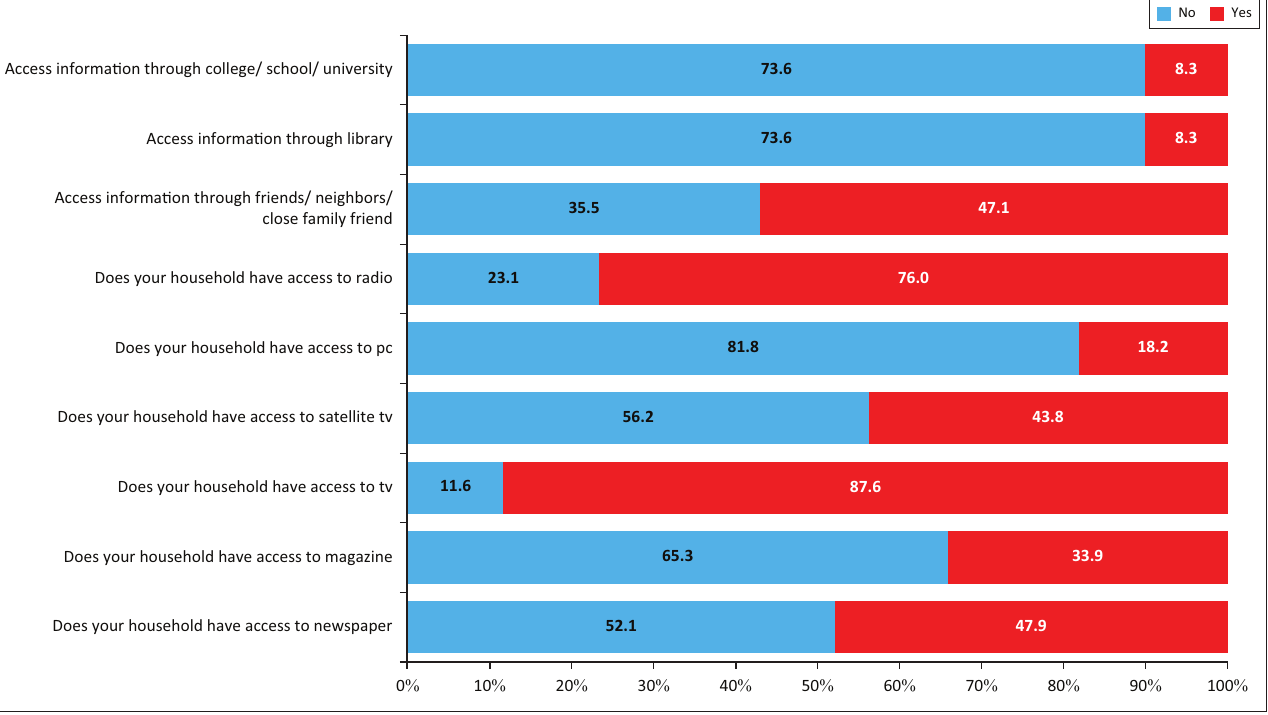
FIGURE 1: Household access to information and communication